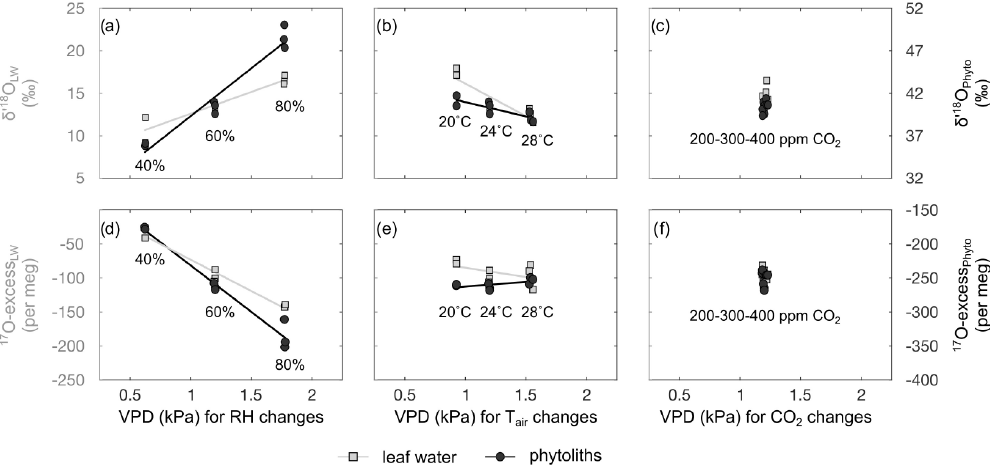
Figure 3. Impact of VPD changes associated with RH, T air and CO 2 concentration (CO 2 ) changes on δ (cid:48) 18 O and 17 O excess values of leaf water and phytoliths. Error bars on the measurement replicates are smaller than the